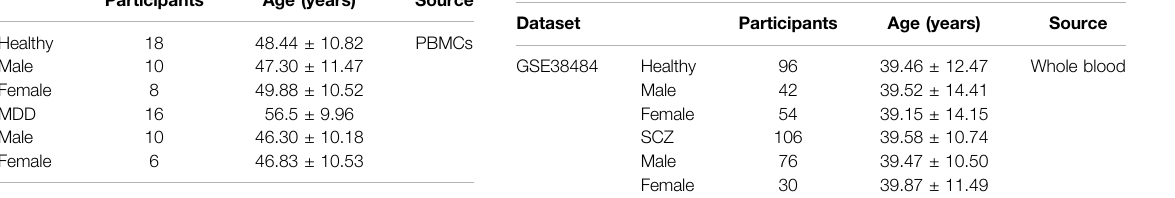
TABLE 3 | Clinical and demographic characteristics of participants (GSE38484) included in the present study.